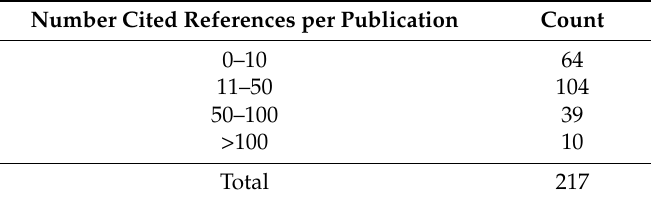
Table 3. Citing behavior of independent